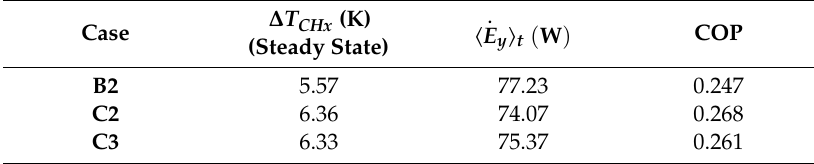
Table 6. Performance results for Kapton-based material combinations of